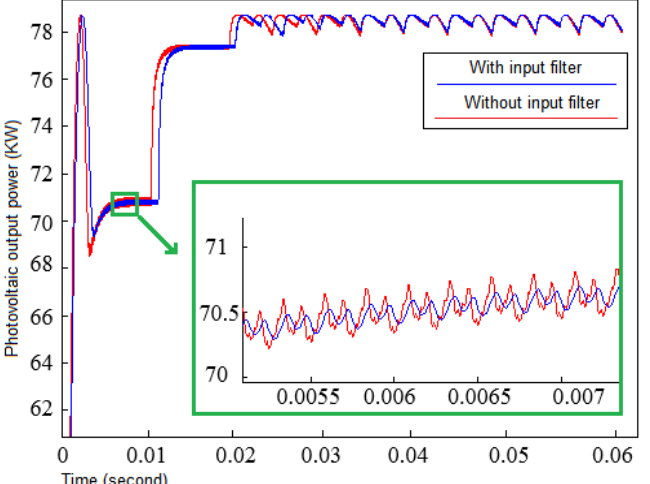
Figure 11. The generated PV power under a transient startup condition with/without the designed damped input filter.